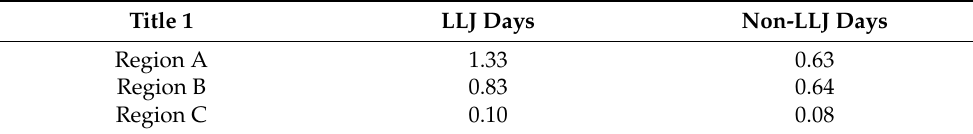
Figure 11. Semi-diurnal variations in the chl-a concentration on LLJ and non-LLJ days in regions ( a ) A, ( b ) B, and ( c ) C (shown by the black boxes in Figure 4i). Table 1. Daily amplitude of chl-a concentrations on LLJ and non-LLJ days in regions A, B, and C (shown by the black boxes Figure 4i).